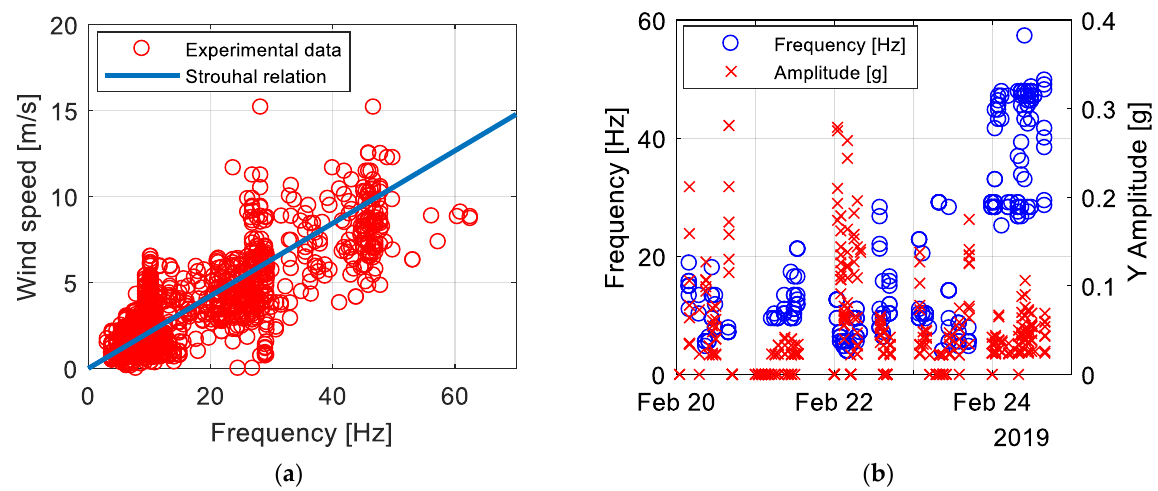
Figure 12. Manitoba test results: ( a ) Comparison between experimental data and Strouhal relation and ( b ) experimental data representing amplitudes and frequencies of vibration.